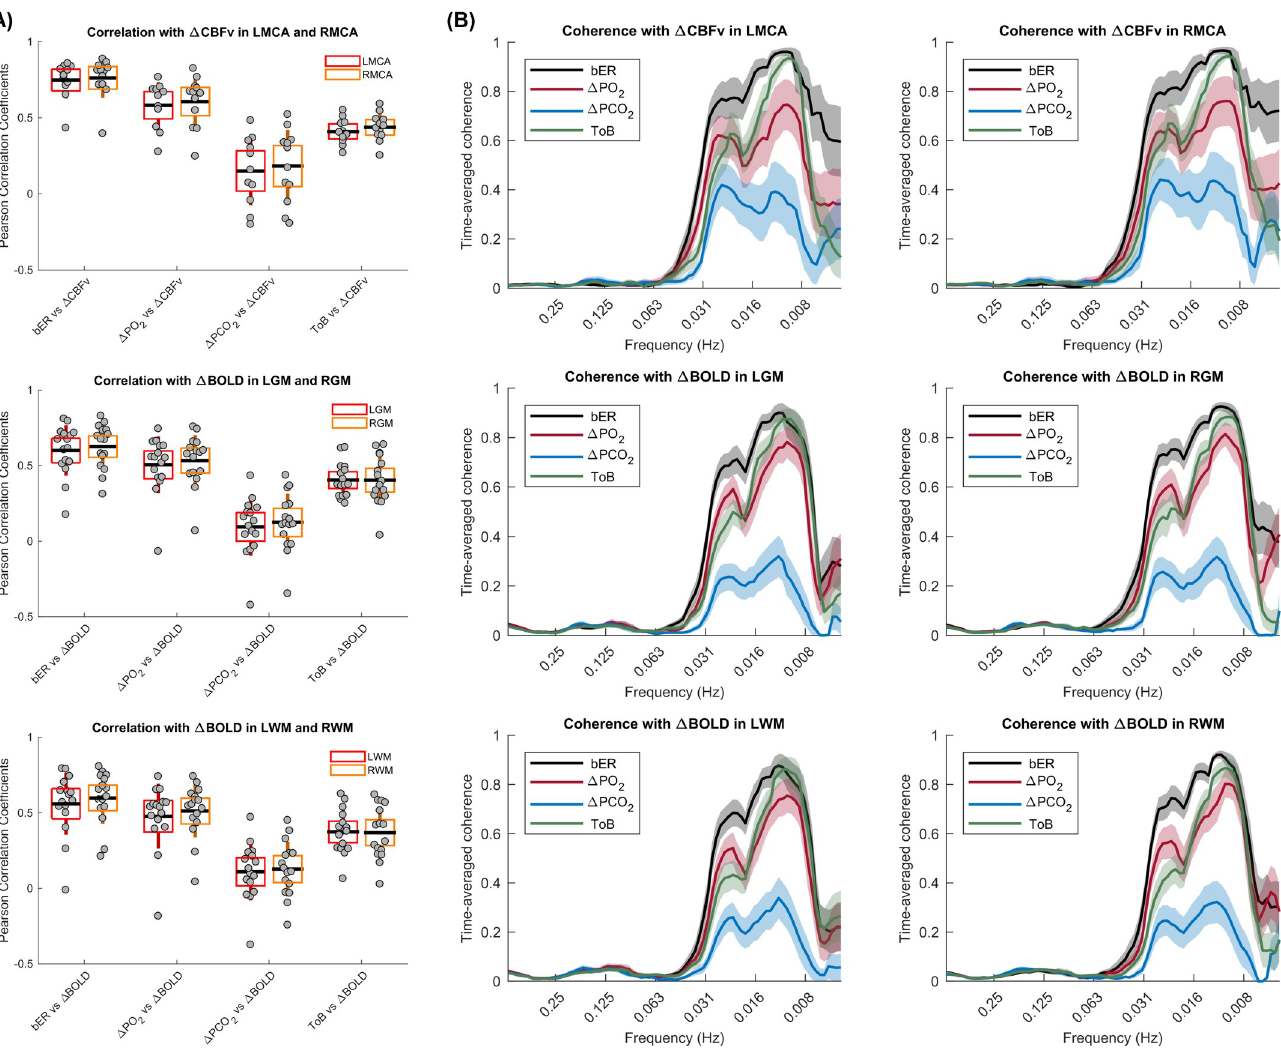
Fig 3. Correlation and coherence between cerebral hemodynamic responses and RGE metrics in all subjects under breath hold challenge. (A) Strength of correlation between cerebral hemodynamic responses and respiratory metrics including bER, Δ PO 2 , Δ PCO 2 and ToB. Top panel shows the correlation with Δ CBFv in LMCA and RMCA (n = 12), the middle panel shows the correlation with Δ BOLD in LGM and RGM (n = 16), and the bottom panel shows the correlation with Δ BOLD in LWM and RWM (n = 16). Each grey circle represents the Pearson’s correlation coefficient from the correlation analysis of the parameter pairs shown on x-axis for each subject. The thick horizontal black line, the box and the vertical rod represent the mean, 95% confidence interval and standard deviation of the group data respectively. The cerebral hemodynamic responses correlate with the respiratory metrics consistently in a descending order of bER, Δ PO 2 , ToB and Δ PCO 2 . (B) Distribution of time-averaged coherence at the phase lag 0 ±π /2 between time series of respiratory metrics (bER, Δ PO 2 , Δ PCO 2 and ToB) and cerebral hemodynamic responses. Top panel shows the coherence with Δ CBFv in LMCA and RMCA (n = 12), the middle panel shows the coherence with Δ BOLD in LGM and RGM (n = 16), and the bottom panel shows the coherence with Δ BOLD in LWM and RWM (n = 16). The mean time-averaged coherence in the frequency bandwidths from 0.008 to 0.25Hz were plotted (thick color lines). Color shaded areas represent standard error of the mean. The mean time-averaged coherence between bER and cerebral hemodynamic responses reached 0.6 or above at the frequency range from 0.008Hz (1/128 seconds) to 0.03Hz (1/32 seconds), while the mean time-averaged coherence between Δ PCO 2 and cerebral hemodynamic responses stayed below 0.4. Comparing with Δ PCO 2 , the mean time-averaged coherence of Δ PO 2 with cerebral hemodynamic responses reached 0.5 or above in the frequency range of 0.008–0.03Hz, which was better than that of Δ PCO 2